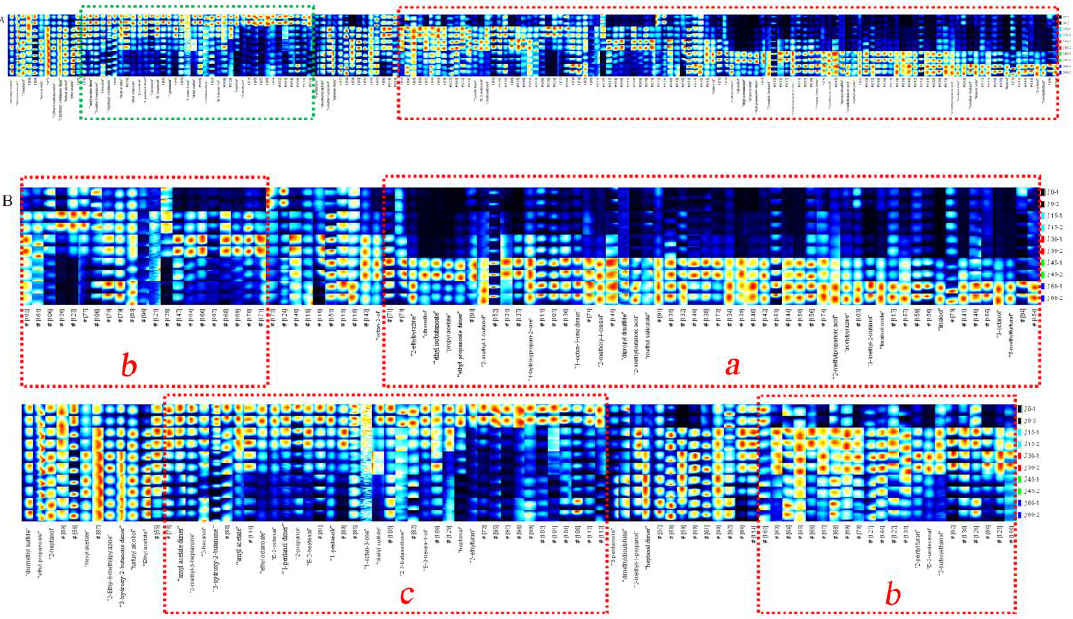
Figure 5. Fingerprint of volatile compounds of Jinsixiaozao samples. ( A ) Fingerprint of all Jinsixiaozao, ( B ) two parts of the fingerprint.